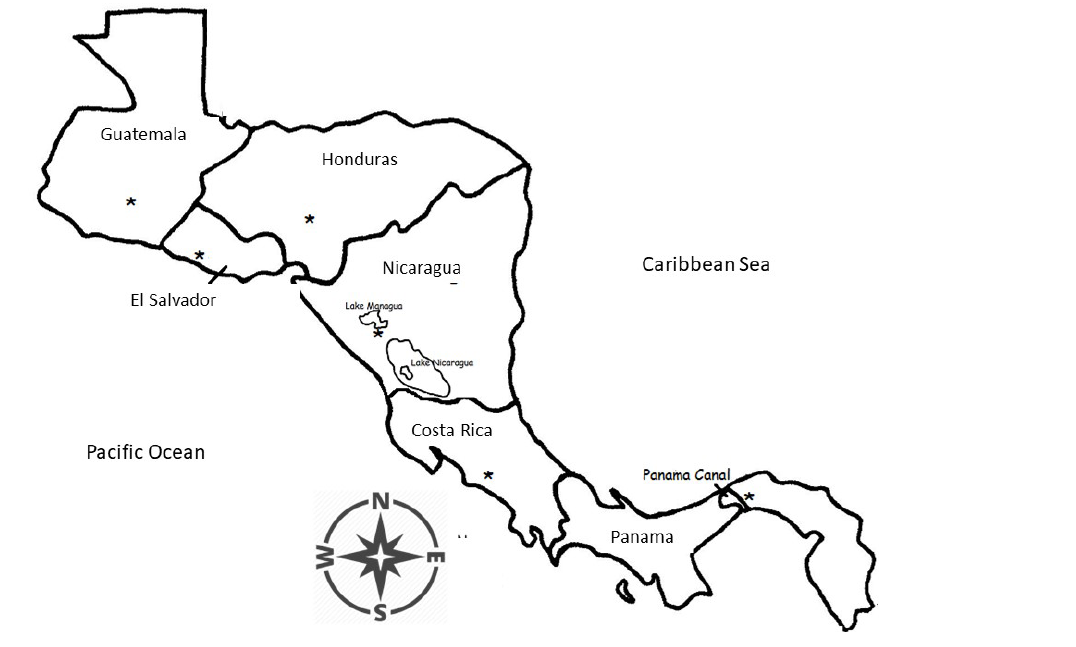
Figure 1. Study area. Table 1. Combination of GCMs and two RCMs for historical and scenarios simulations (see http://www.cordex.org, last access: 26 Septem- ber 2022, for acronyms and models